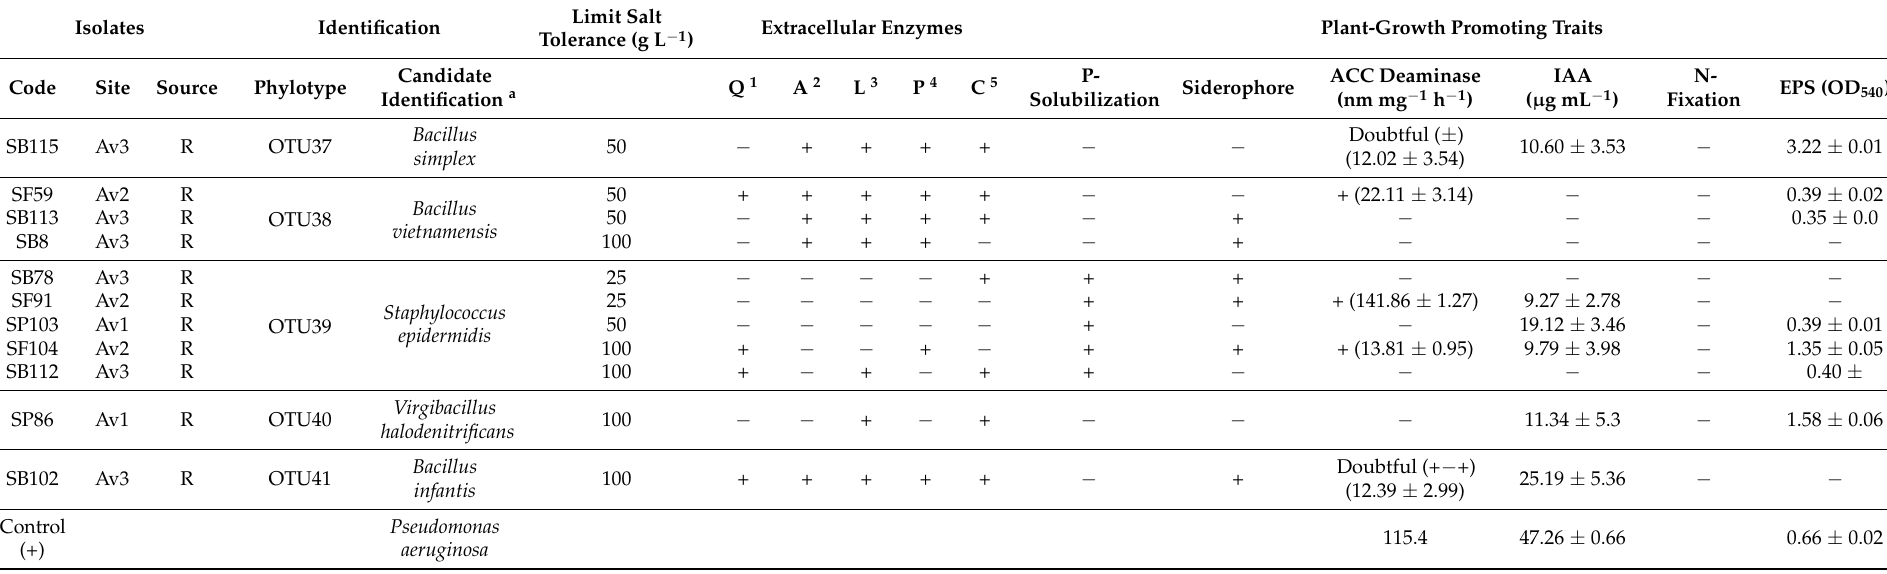
growth on solid DF +ACC